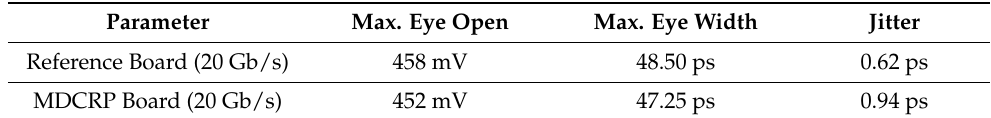
Figure 10. Eye diagram of the differential signals of the measured results. ( a ) The reference boards. ( b ) The MDCRP structure filter board. Table 2. Comparison of the differential eye diagram parameters of the measured